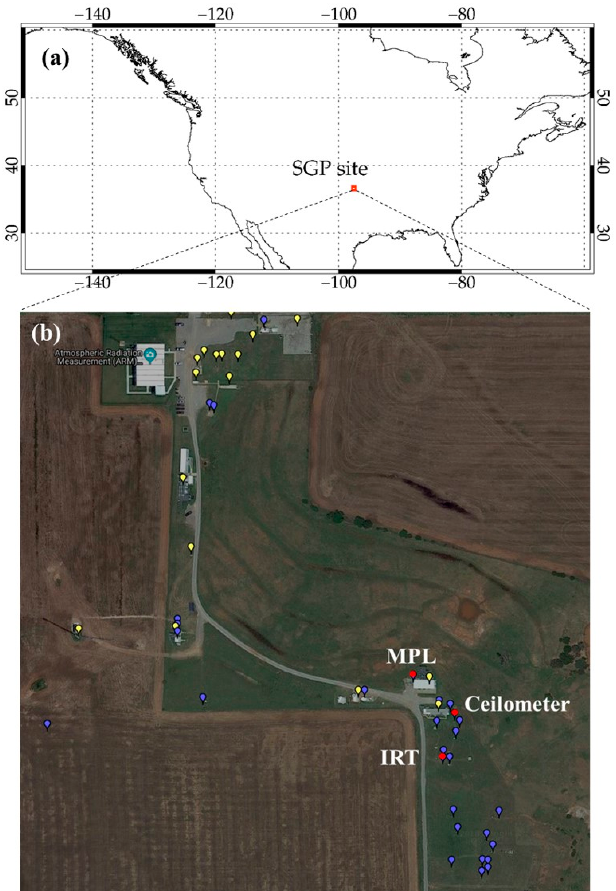
Figure 1. The Southern Great Plains (SGP) site located at the mid-latitude climate zone (36°36 ′ 18.0 ″ N, 97°29 ′ 6.0 ″ W, and 318 m above sea level) ( a ) and its site map including the location of the infrared thermometer (IRT), ceilometer, and micro-pulse lidar (MPL) ( b ). The red circles indicate the location of each instrument utilized in the current study (image source: http://www.arm.gov/sites/sgp).